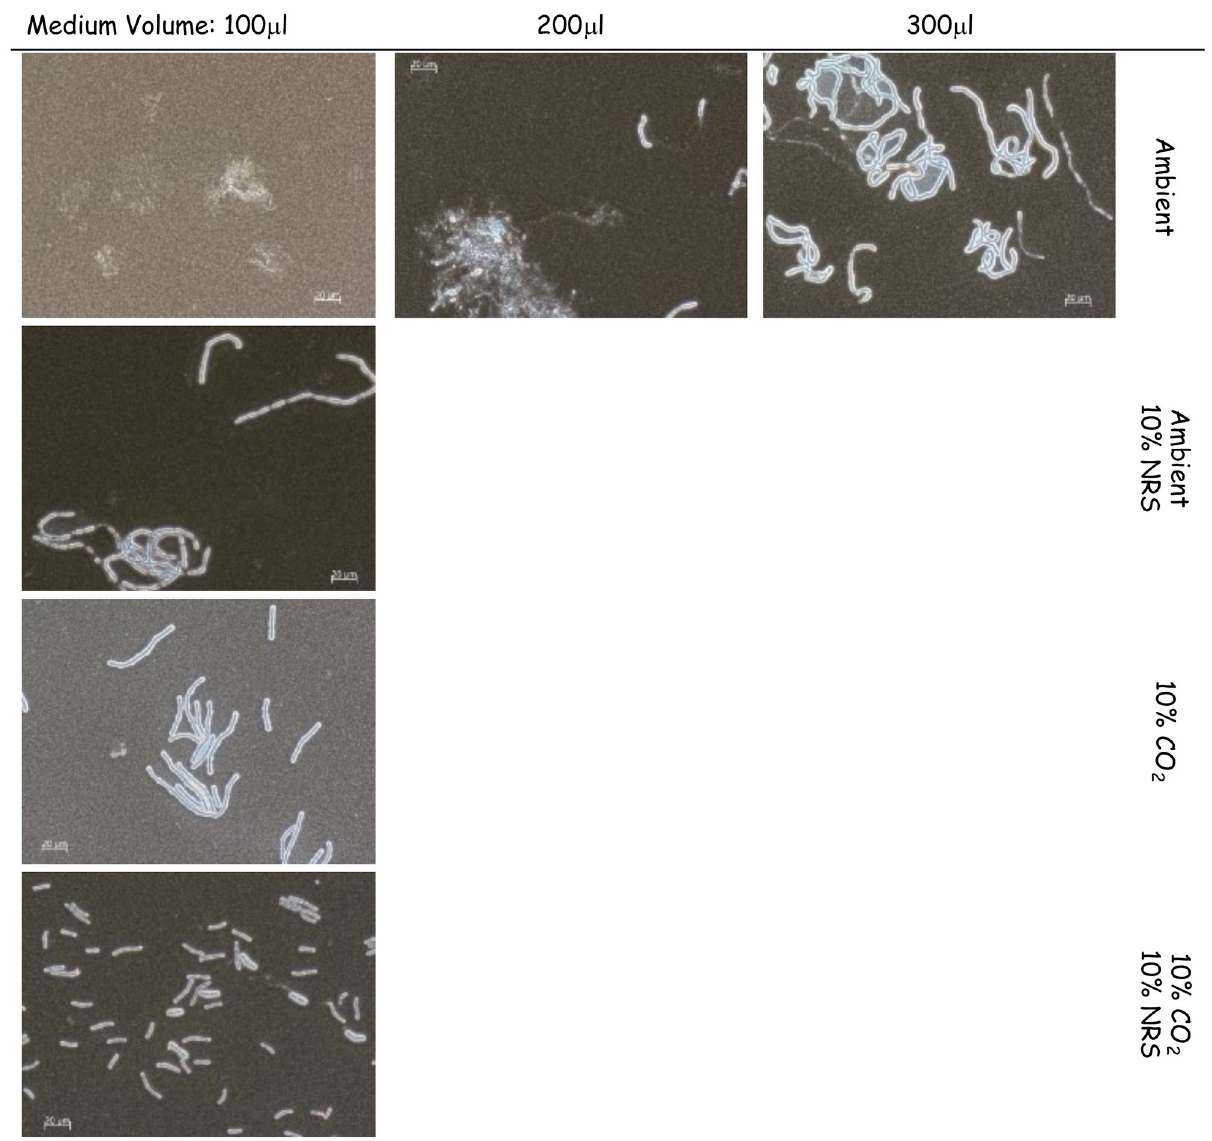
Fig 1. The effect of growth conditions on capsule induction by B . anthracis Vollum. Spores were seeded into 100 μ l, 200 μ l or 300 μ l of sDMEM and incubated at 37˚C in an ambient atmosphere (upper panel) for 24h. To examine the effect of serum or CO 2 on capsule production, spores were seeded into 100 μ l sDMEM or sDMED-NRS (supplemented with 10% NRS). Samples were incubated at 37˚C in under ambient or 10% CO 2 atmosphere (see right hand side legend) for 24h. Capsule was imaged by India ink negative staining (capsule presence forms a typical bright outer